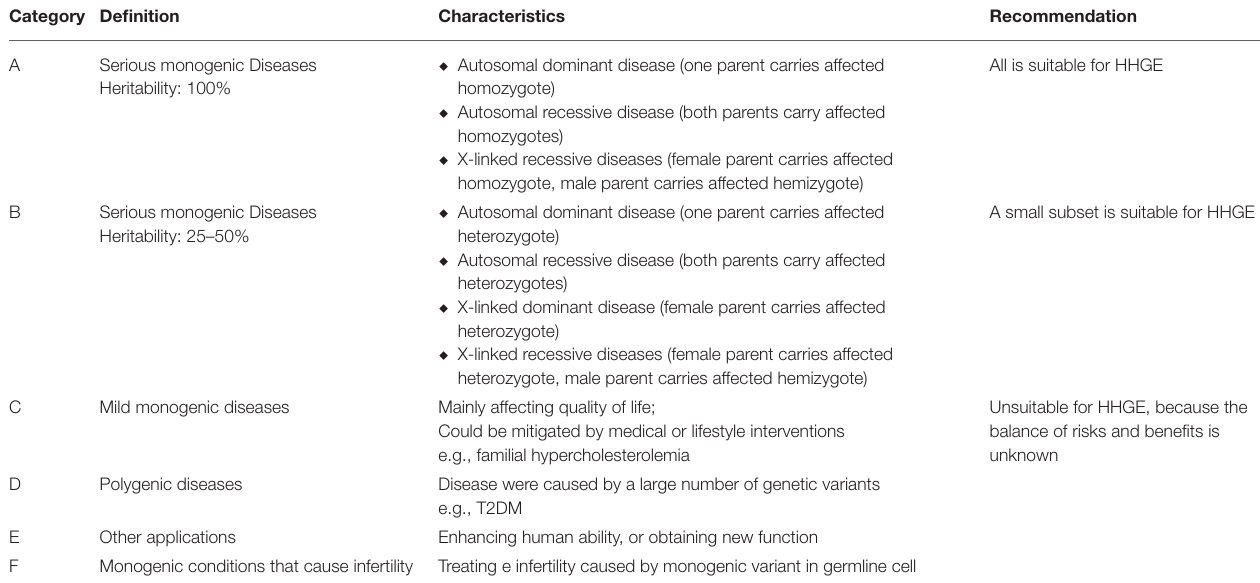
TABLE 1 | Category of applications of HHGE and the recommendation from International Commission on the Clinical Use of Human Germline Genome Editing. Category